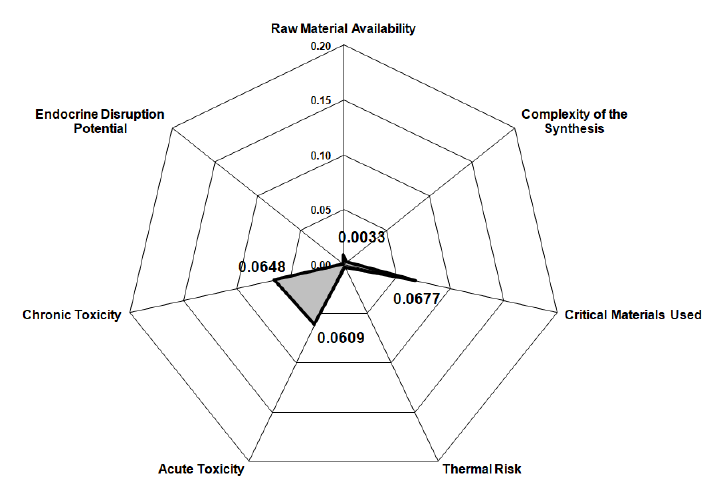
Figure 4. Environmental impact assessment for input streams.